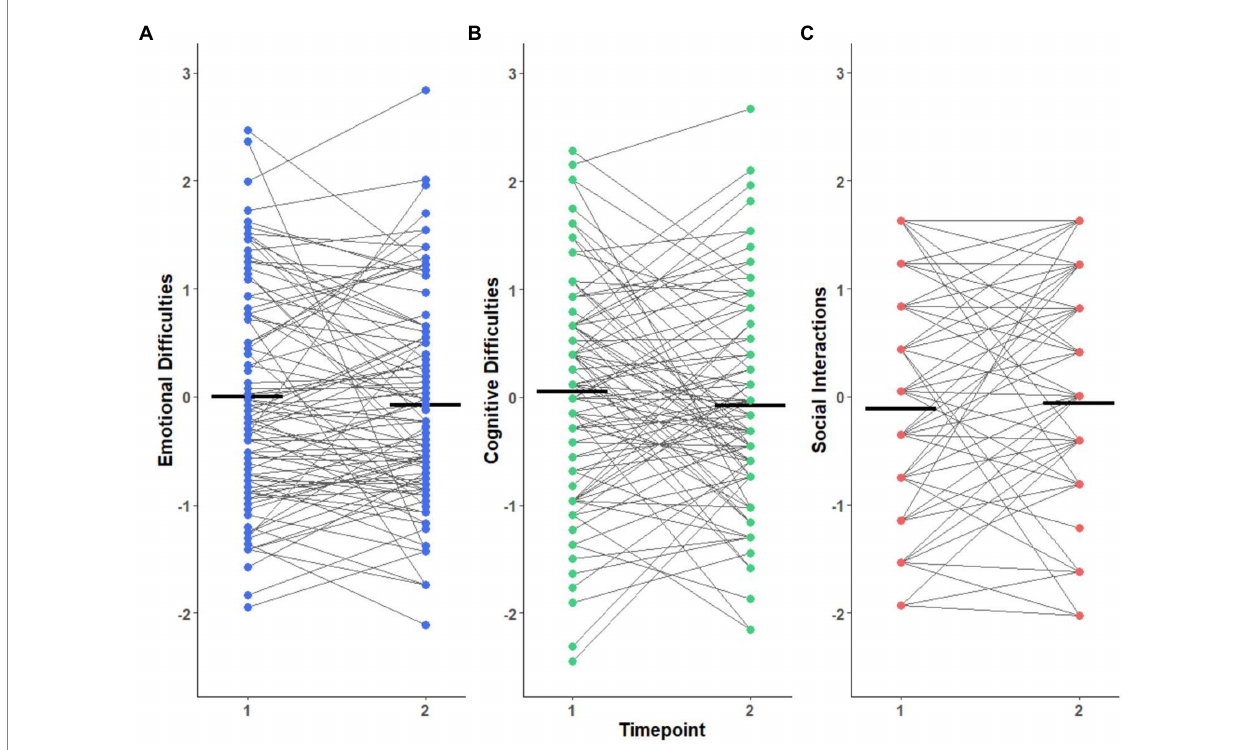
FIGURE 2 Early and Mid-COVID-19-Era experience change. Individual change in CASPE scores between early and mid-pandemic collection timepoints ( n = 93). (A) Emotional difficulties, (B) Cognitive difficulties, and (C) Social interactions. Points represent individual participants, with thin lines connecting each participant’s early and mid-pandemic experiences. Bolded horizontal lines indicate group mean within each timepoint. Means were not significantly different, but this masked considerable individual variability. The x-axis (timepoint) is the same across all three